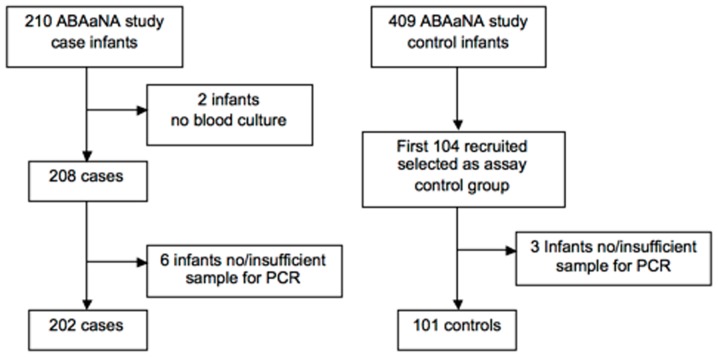
Flow diagram of study case and control participant.